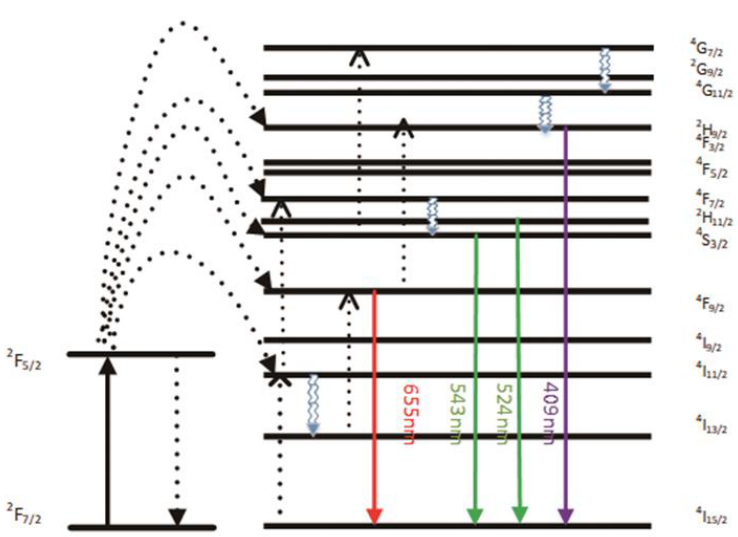
Figure 5. A simplified energy level diagram of Er 3+ /Yb 3+ system embedded with AgNPs and possible up-conversion pathways.